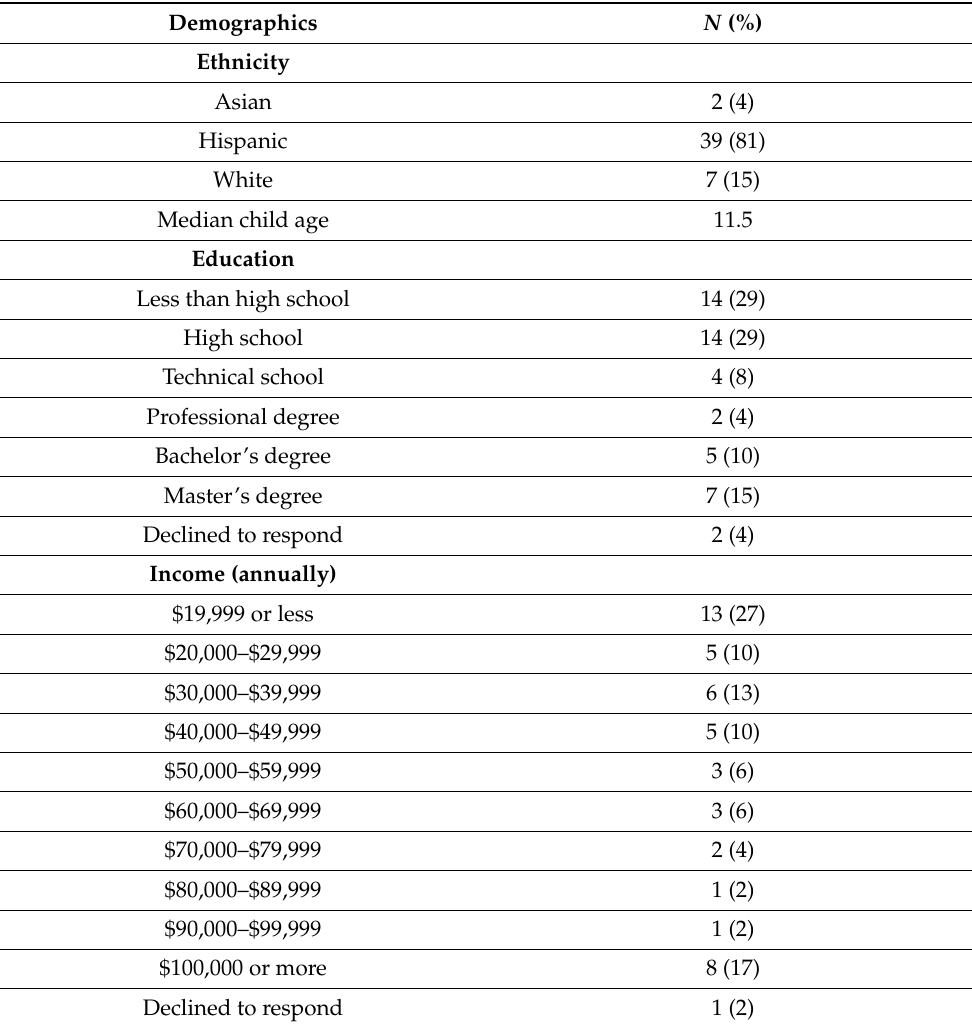
Table 1. Participant characteristics. Income is listed in